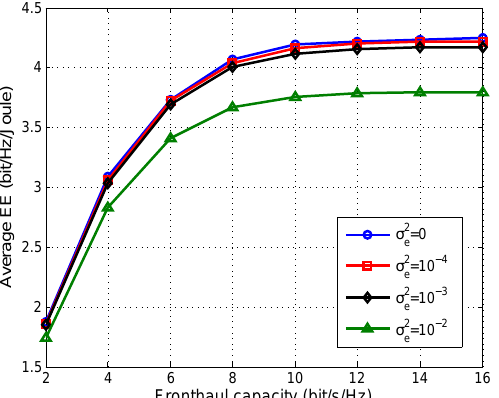
Figure 9. Average EE versus fronthaul capacity with different channel errors, P m = 30 dBm, P c = 2 W and C = 5